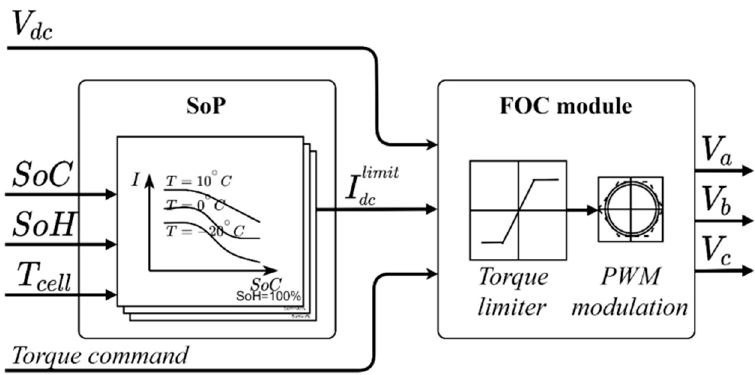
Figure 5. SoP estimation method and its